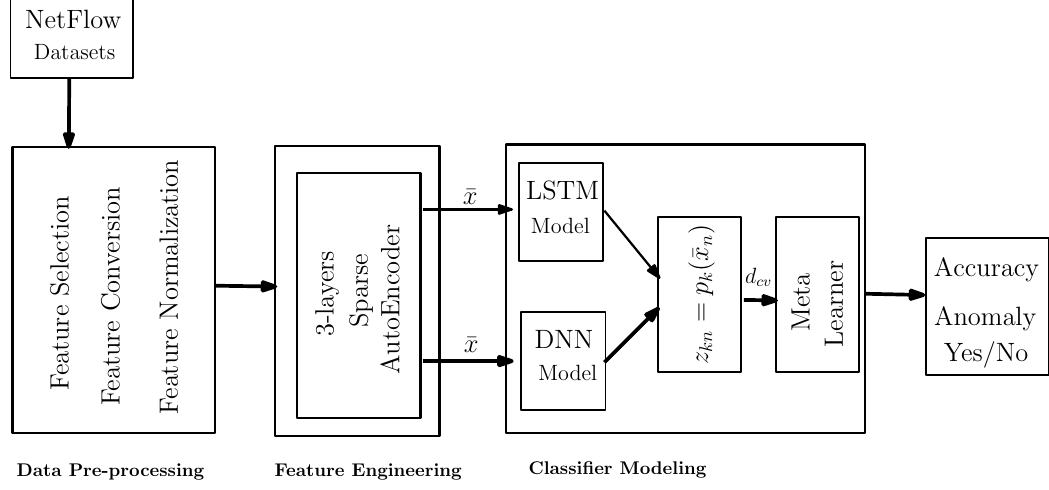
Figure 3. Proposed procedure of constructing a stacked ensemble